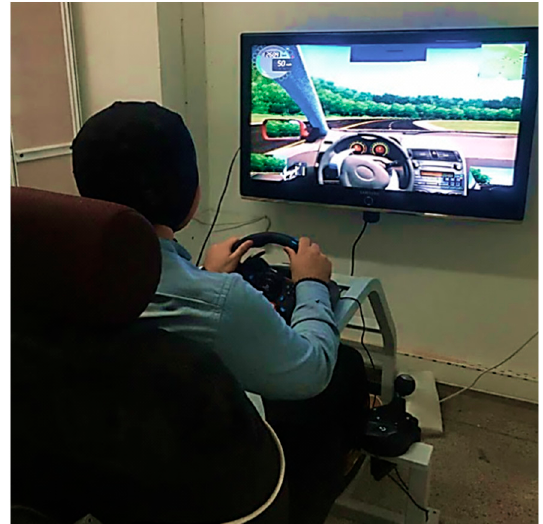
Figure 1. A participant while driving in a driving simulator.